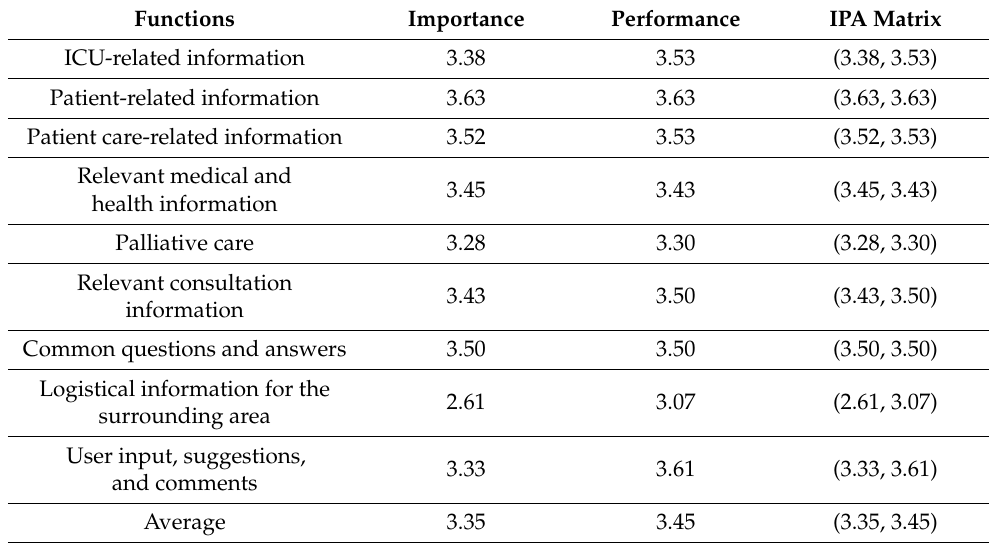
Table 3. Importance–performance analysis of the ICU-SSS functions.